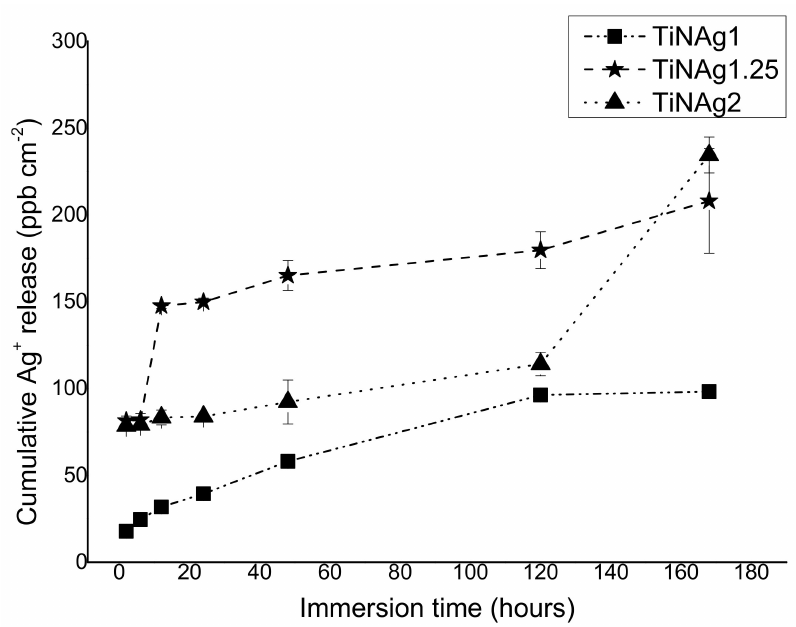
Figure 4. Ag + release along time (2 h, 6 h, 12 h, 24 h, 48 h, 120 h and 168 h) determined by ICP-OES